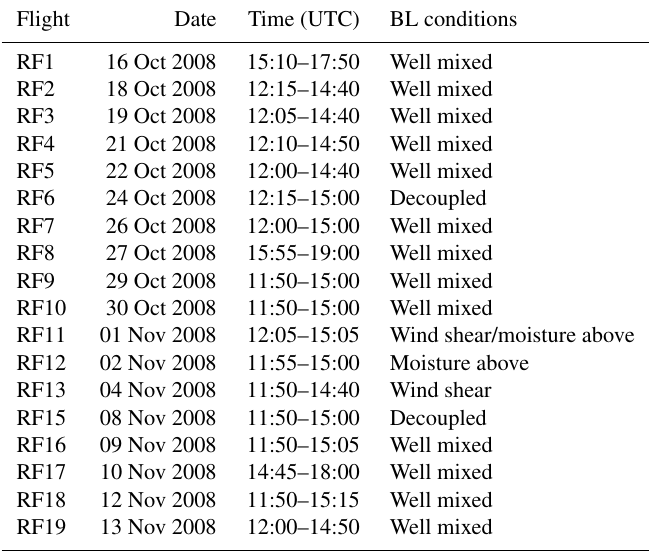
Table 1. Column (1): research flight (RF) identification; column (2): the corresponding date; column (3): flight start and end times at Point Alpha. Note that local time is 04:00UTC. Column (4): boundary layer conditions for each